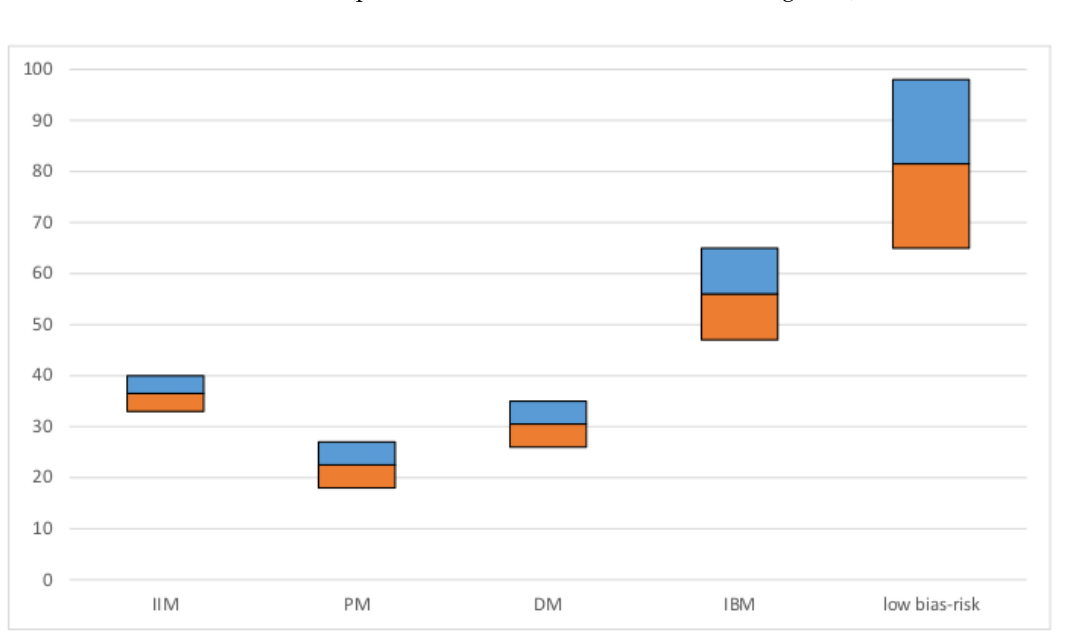
Table 1. The estimate of the pooled prevalence, the 95% confidence interval (CI), the number of included studies and subjects, I 2 as measure for heterogeneity, p -value of the Egger’s test and percentage of studies with low risk of bias for all meta-analyses.